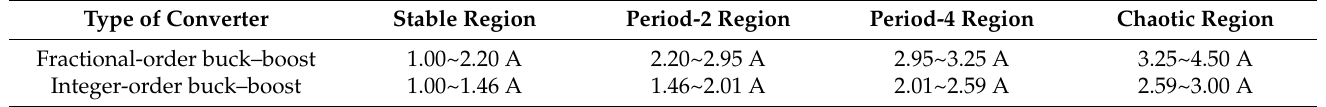
verters. Table 2. Reference current value range of fractional-order and integer-order DCM buck–boost converters.